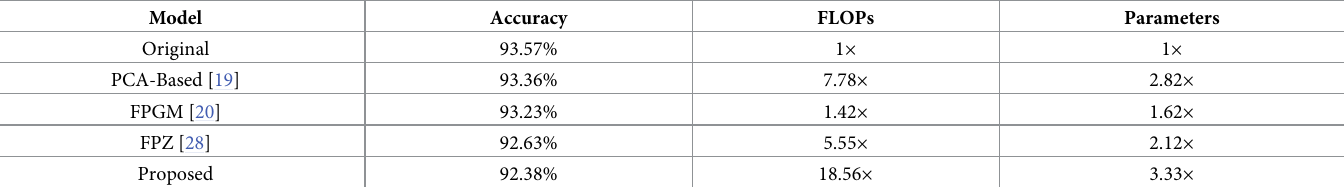
Table 4. Comparison of VGG-16 on CIFAR-10.